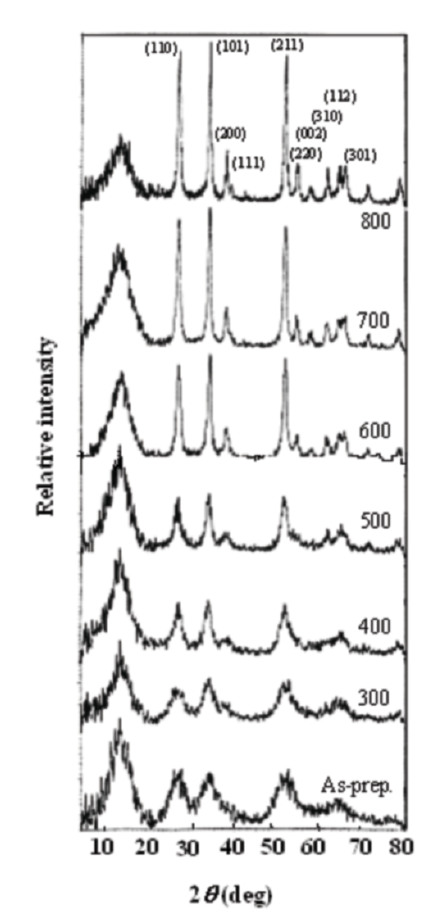
Figure 3. XRD spectra of the as-prepared SnO acid based sol-gel method, and its respective annealed samples at different temperatures.